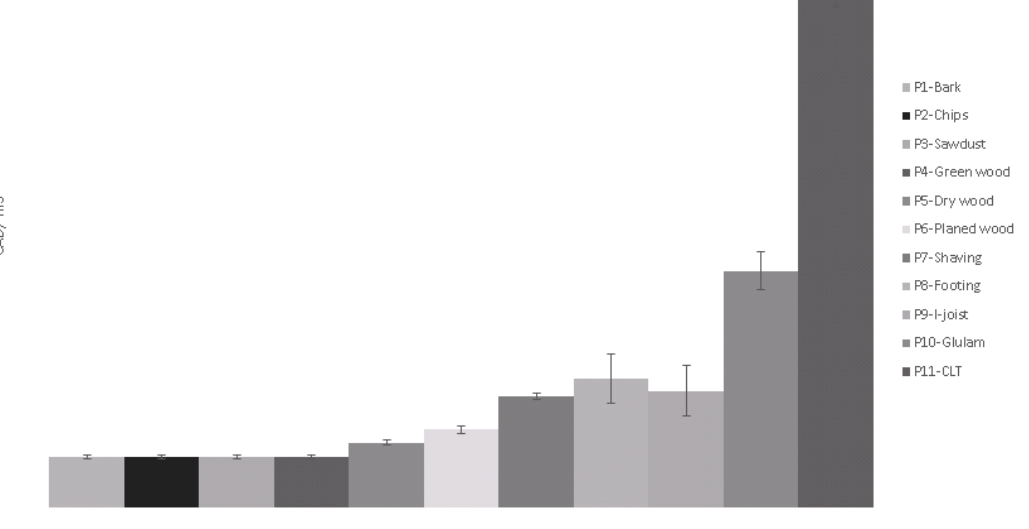
Figure 4: Results of the products portfolio costs, calculated by the activity based life cycle costing method